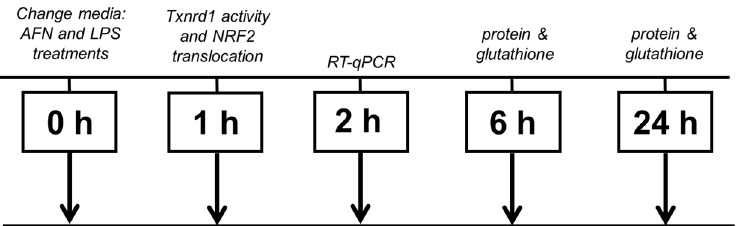
Figure 1. The time course for analyses. MH-S cells were cultured, exposed to lipopolysaccharide (LPS), buthionine sulfoximine (BSO), and/or auranofin (AFN), and harvested at the time points that were relevant for the respective endpoint. Phosphorylation of cytoplasmic factors, I κ B α and p65 NF κ B, and nuclear localization of NRF2 and NF κ B occurred rapidly and were assessed at 1 h, and for transcripts of NLRP3 and IL-1 β a timepoint of 2 h was chosen. Both protein and glutathione levels were measured at either 6 or 24 h to allow enough time for transcription and translation of IL-1 β and other protein mediators of de novo glutathione synthesis.